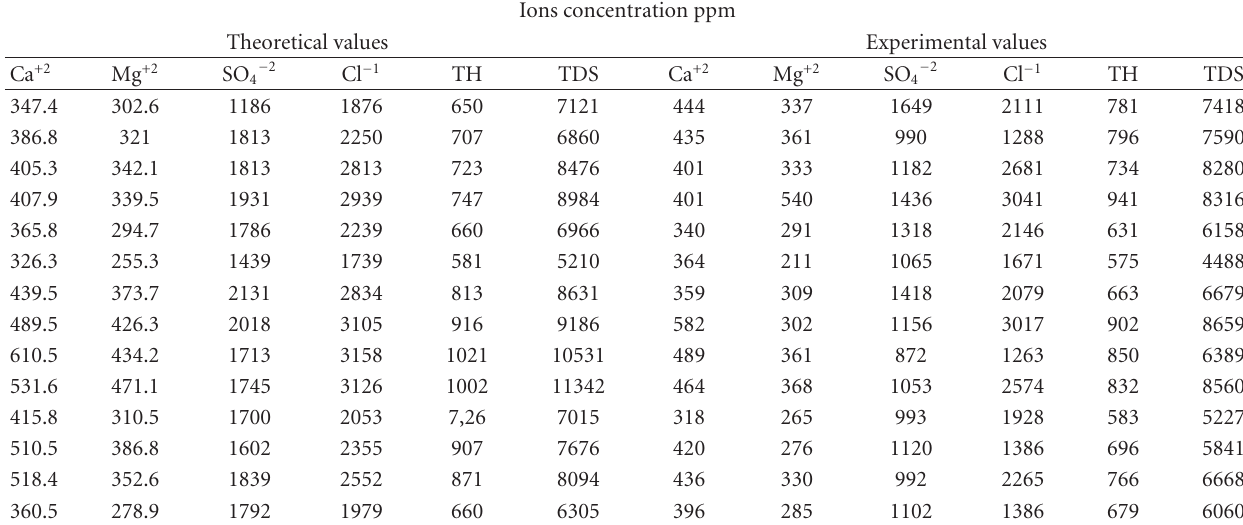
Table 2: Theoretical and experimental values of ions in the rejected stream for fourteen samples.